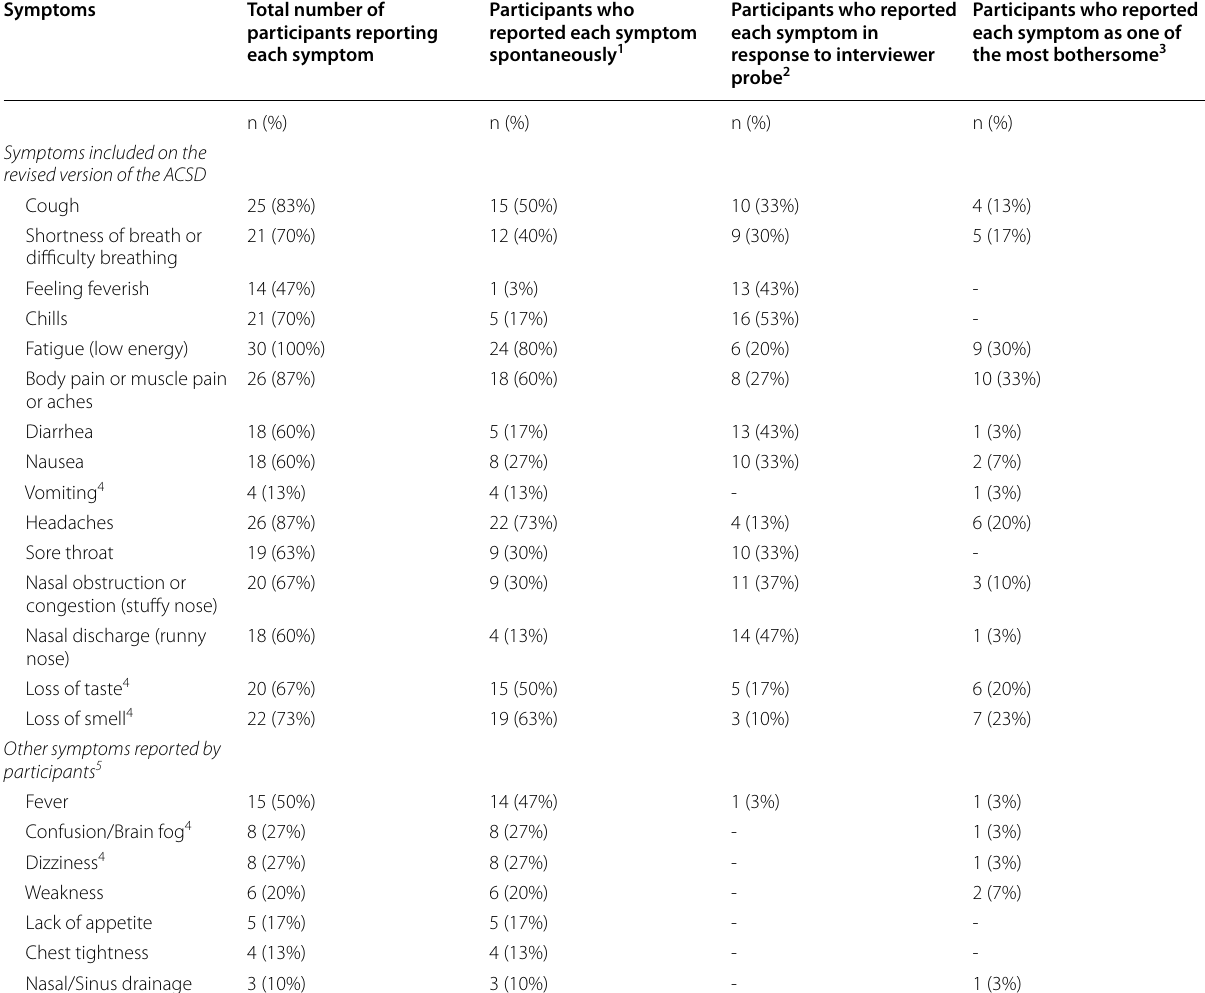
Table 2 COVID-19 Symptoms Reported by Participants (N